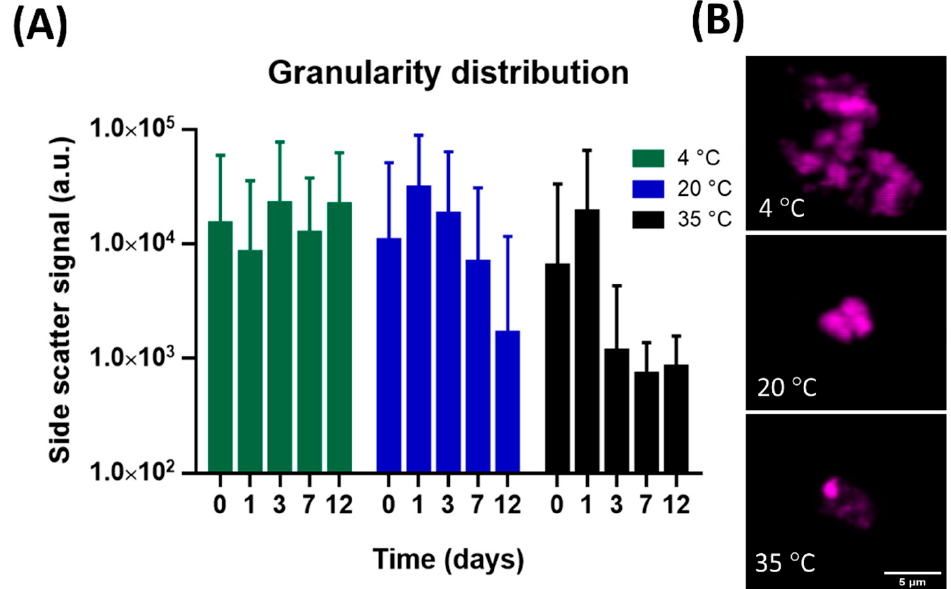
Figure 2. Temperature reduces microgel granularity. ( A ) The microgel granularity distribution from the flow data. Each column represents the mean ± SEM of side scatter signal in the flow data. ( B ) Confocal laser scanning micrograph showing the microgel structure and the hydrophobic sites at 4, 20, and 35 °C. Scale bar: 5 μ m.